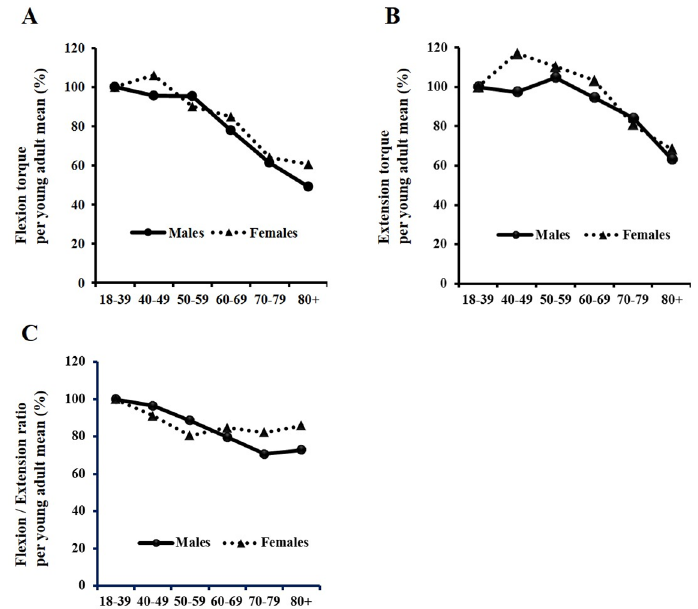
Fig 4. Age-related change in trunk flexion torque (A), extension torque (B), and flexion/extension ratio (C). The percentage of flexion and extension torque against the reference values for young and healthy adults are shown. Subjects were divided into four groups: < 50 (under 50 years of age), 50–59 (from 50 to 59 years of age), 60–69 (from 60 to 69 years of age), and 70+ (above 70 years of age) in males and